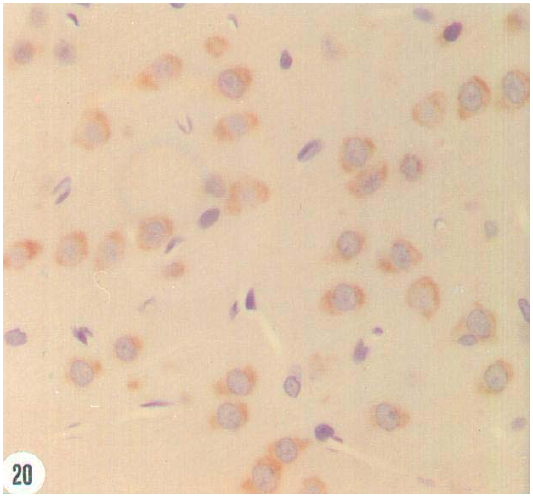
Figure 20 . Highly decreased Bcl-2 immunoreactivity 72 hr after high dose envenoming.